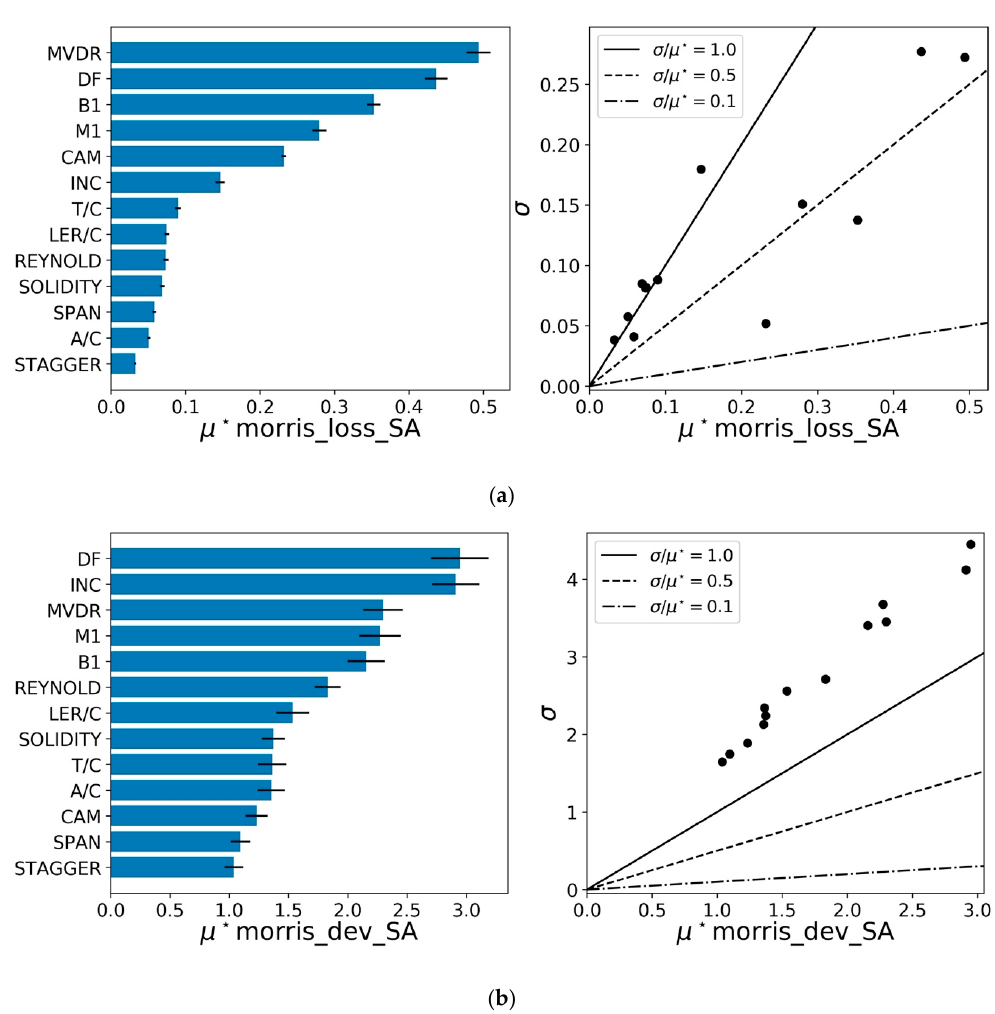
Figure 5. Sensitivity analysis of blade element database: ( a ) Elementary effect distributions of total pressure loss; ( b ) Elementary effect distributions of deviation angle.